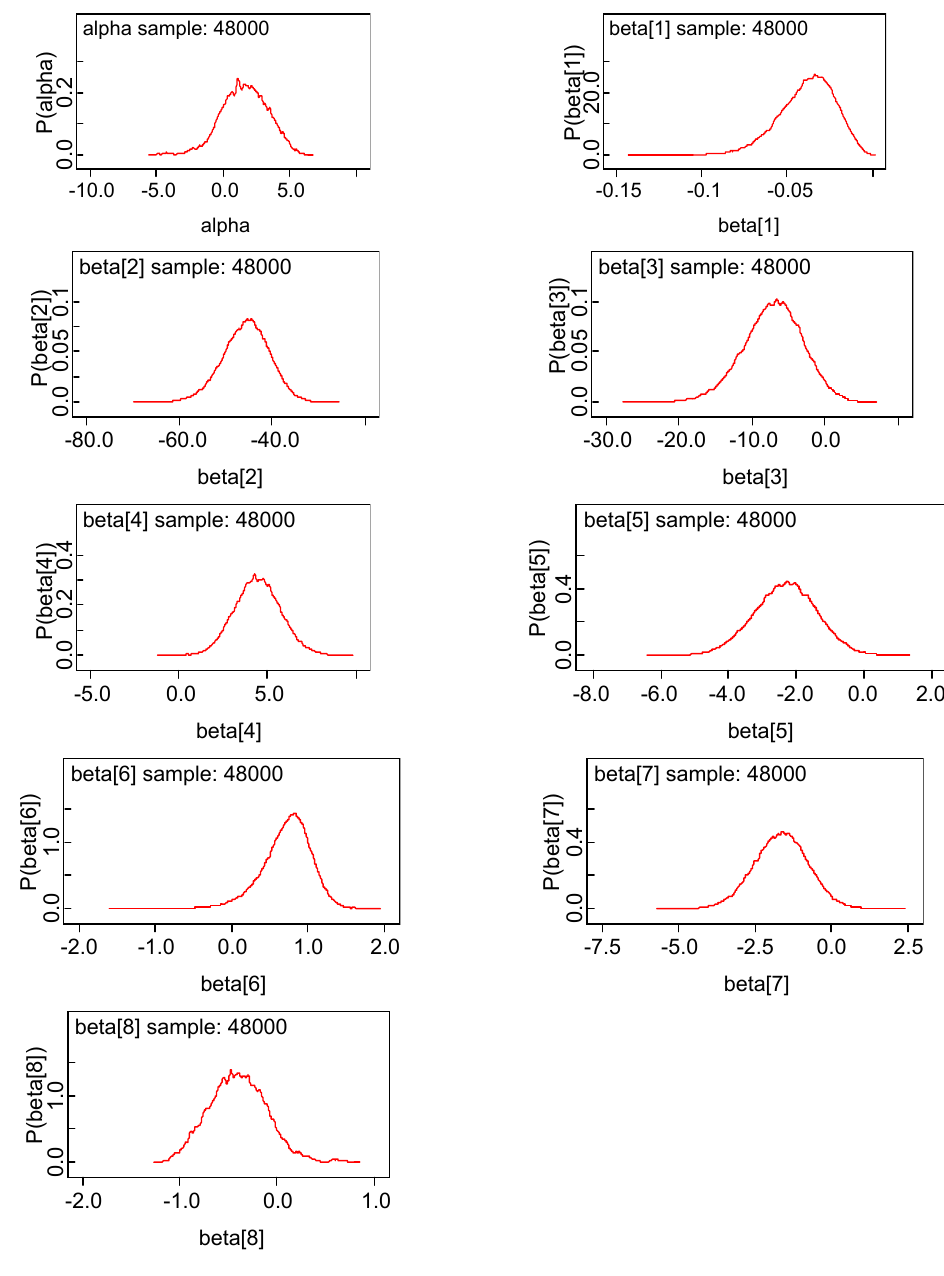
Figure A1. Kernel Density Plot. (b) Random number plot generated from Posterior distribution of the regression